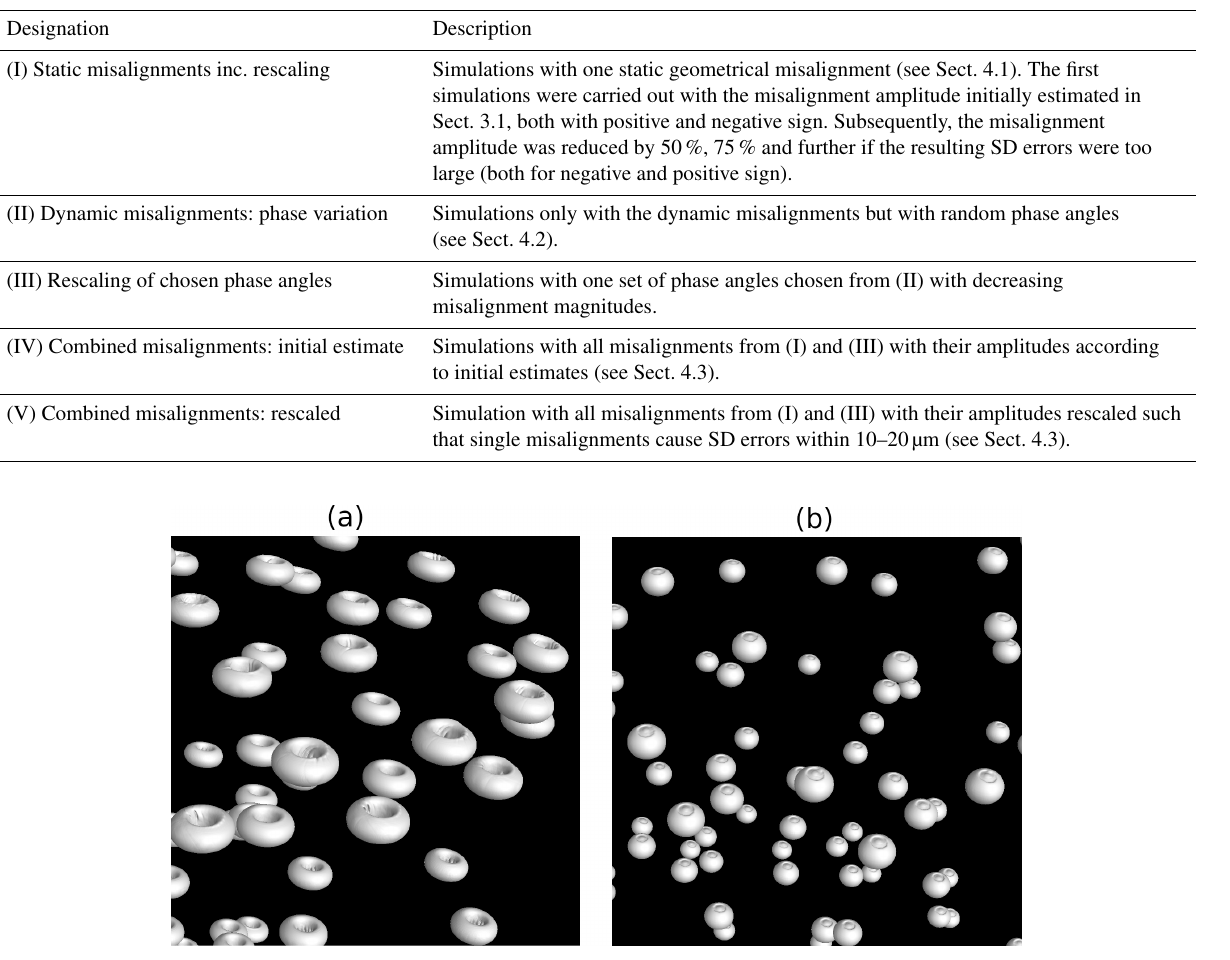
Table 1. Overview of conducted simulations.